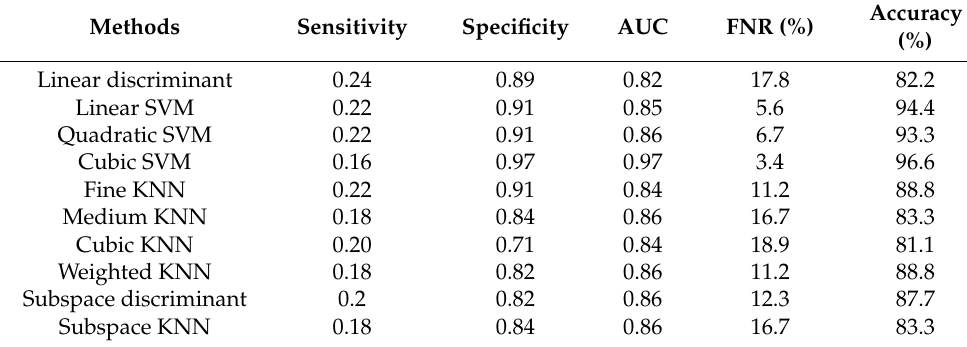
Table 2. Powdery mildew vs. healthy mango leaves.